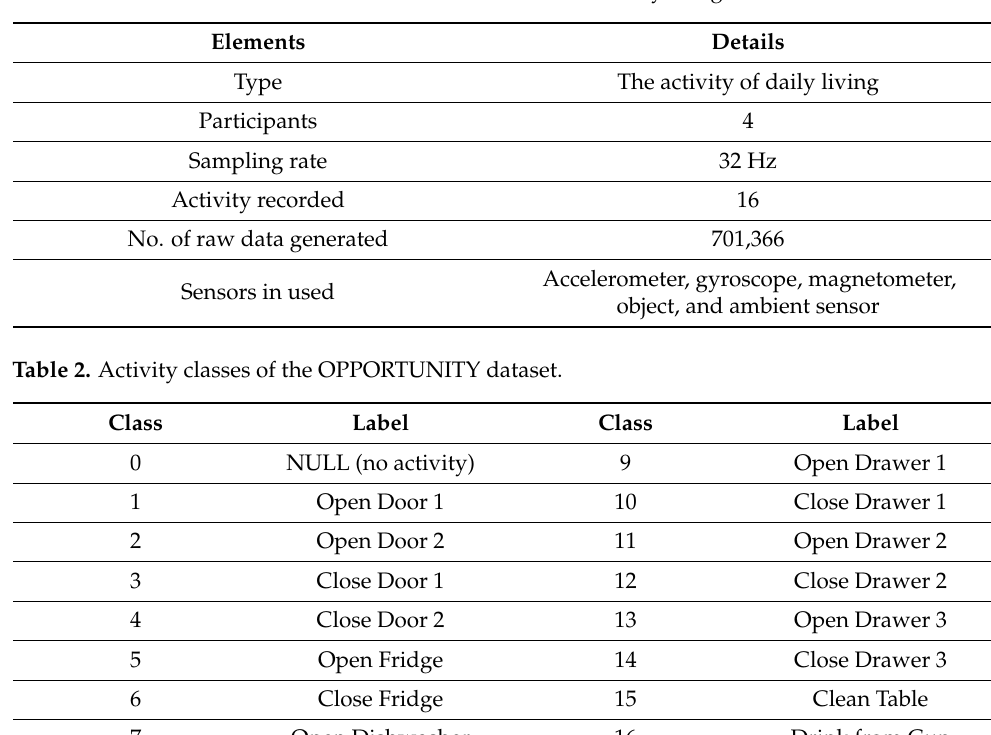
Table 1. Details of the OPPORTUNITY dataset for human activity recognition.